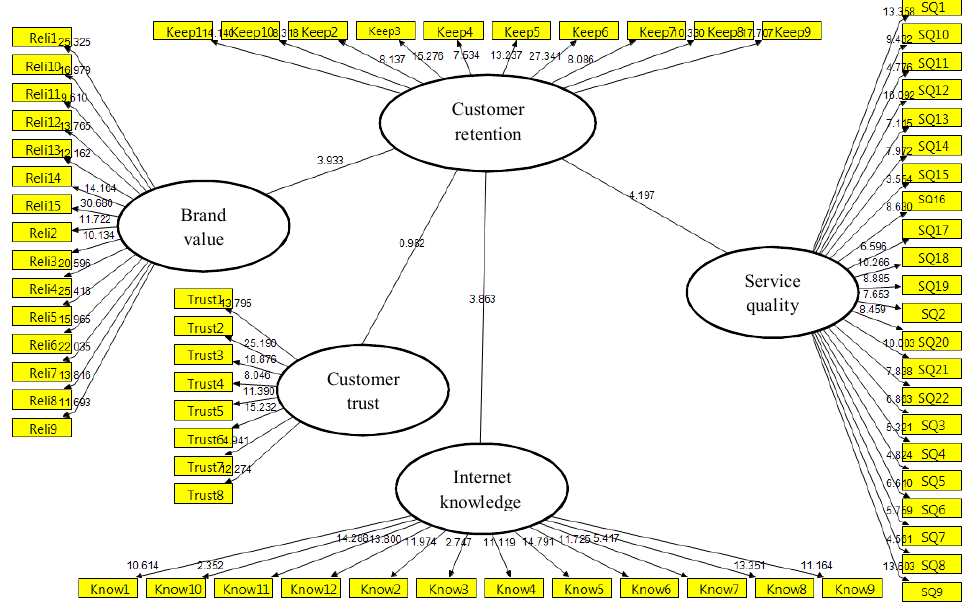
Fig. 3. The results of t-value for the implementation of structural equation